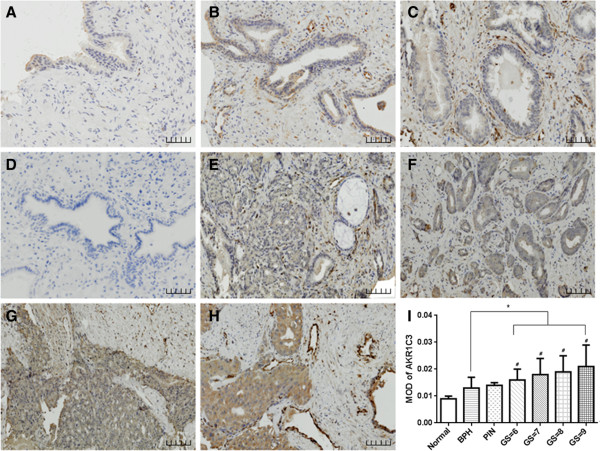
Immunohistochemical staining of AKR1C3 in human prostatic needle biopsies. (A) Normal prostate. (B) BPH. (C) PIN. (D) PBS negative control of prostate cancer tissue. (E)-(H) Different GS prostate cancer tissues. (E) Gleason score = 6. (F) Gleason score = 7. (G) Gleason score = 8. (H) Gleason score = 9. (I) The quantification bar for the MOD of AKR1C3. *P < 0.05, compared with BPH. #P < 0.05, compared with PIN. Scale bar is 50 μm.